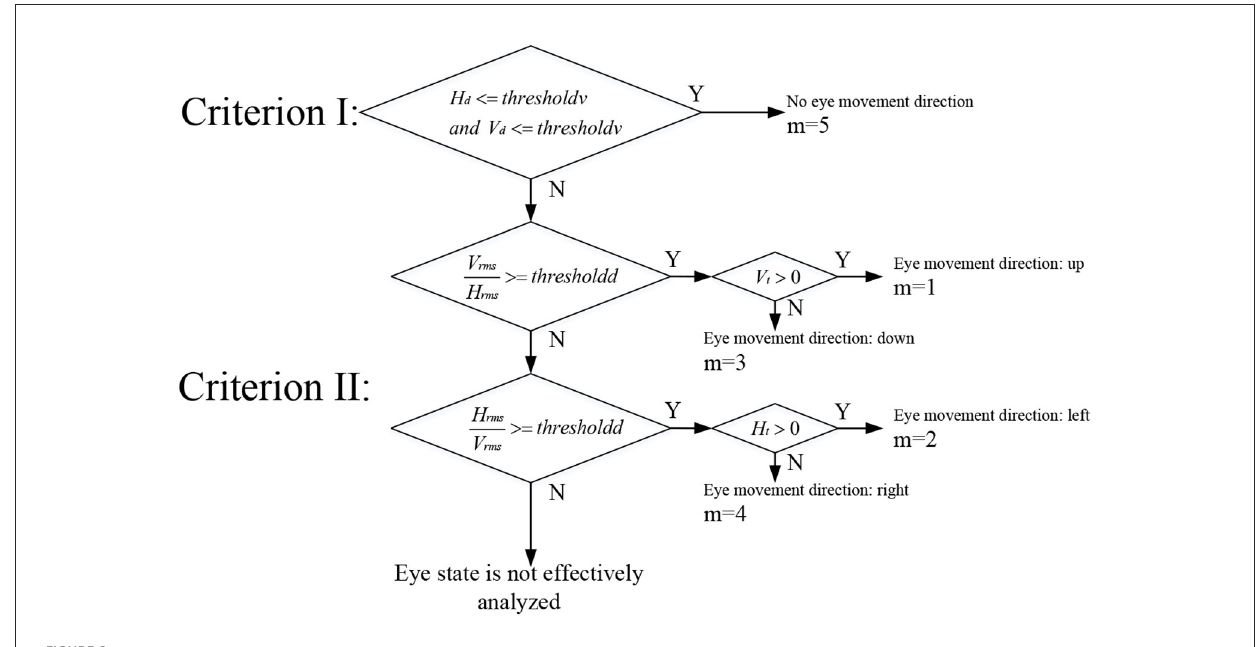
FIGURE6 Flow chart of eye movement